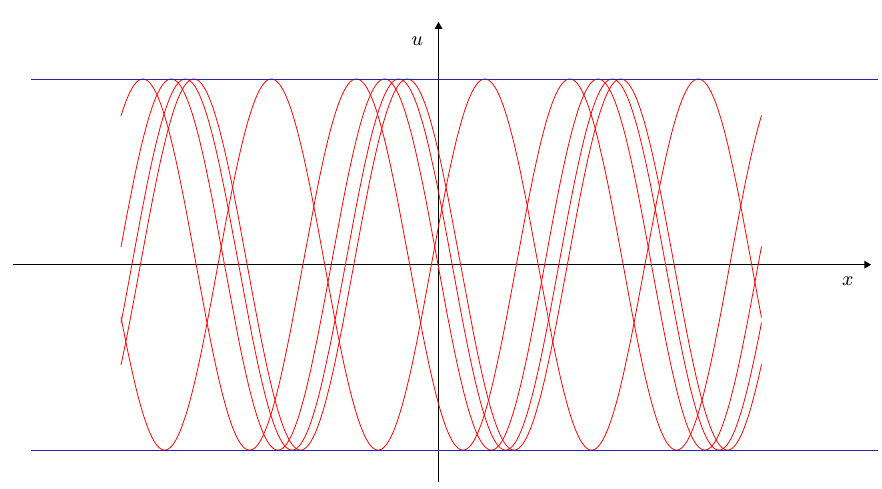
Fig. 8. Singular and regular solutions to ( u ′ ) 2 + u 2 = 1